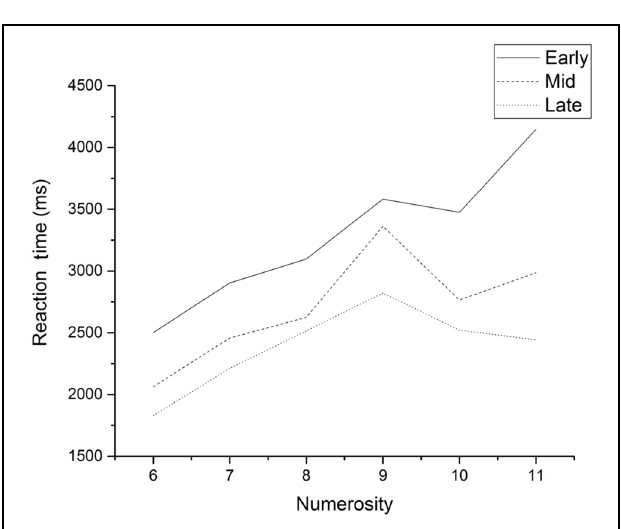
FIGURE 4 | Mean RT as a function of numerosity for the three phases of the